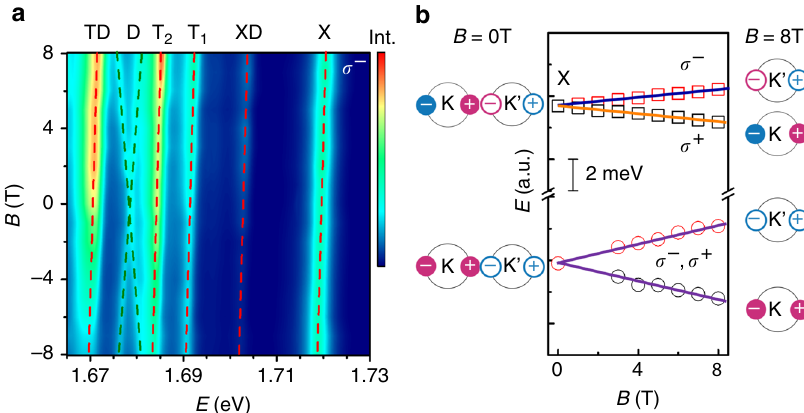
Fig. 4 Magnetic fi eld tuning of the XD and TD emission. a The color map of σ − PL spectra in a perpendicular magnetic fi eld from − 8 to 8 Tesla. b Magnetic fi eld dependence of X and D Zeeman splitting. The K ’ valley states, degenerate with K states at zero fi elds, have higher energies at B = 8 T. The symbols are extracted from data in a . Note that the X emission is valley-helicity locked, while the D emission